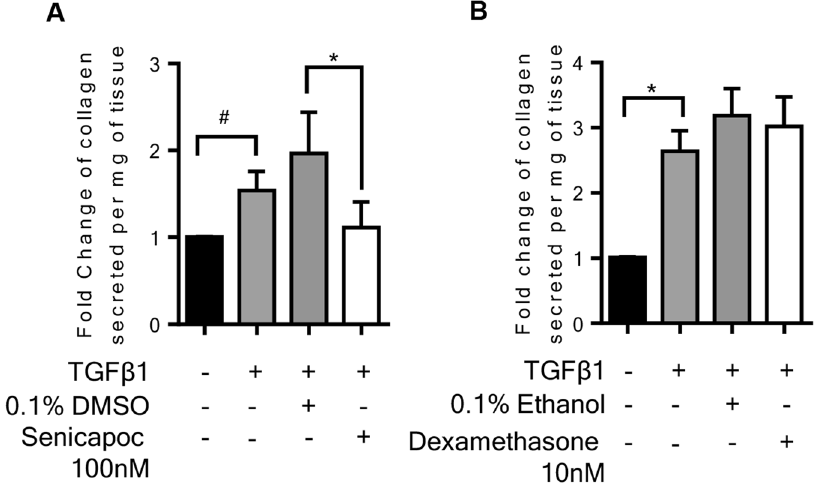
Figure 7. Pharmacological intervention in the fibrogenesis model has varying effects on collagen secretion after 4 days ex vivo culture. ( A ) K Ca 3.1 blockade significantly attenuated collagen secretion into the supernatants following 4 days of ex vivo culture. The amount of collagen secretion was examined per mg of tissue present in the well, n = 5. ( B ) Dexamethasone (10 nM) did not inhibit TGF β 1-stimulated collagen secretion into the supernatants following 4 days of ex vivo culture n = 5. Data are presented as median ± IQR # P < 0.05 (one sample t test), or mean ± SEM * P < 0.05, (1-way ANOVA, corrected by Dunns multiple comparison test).